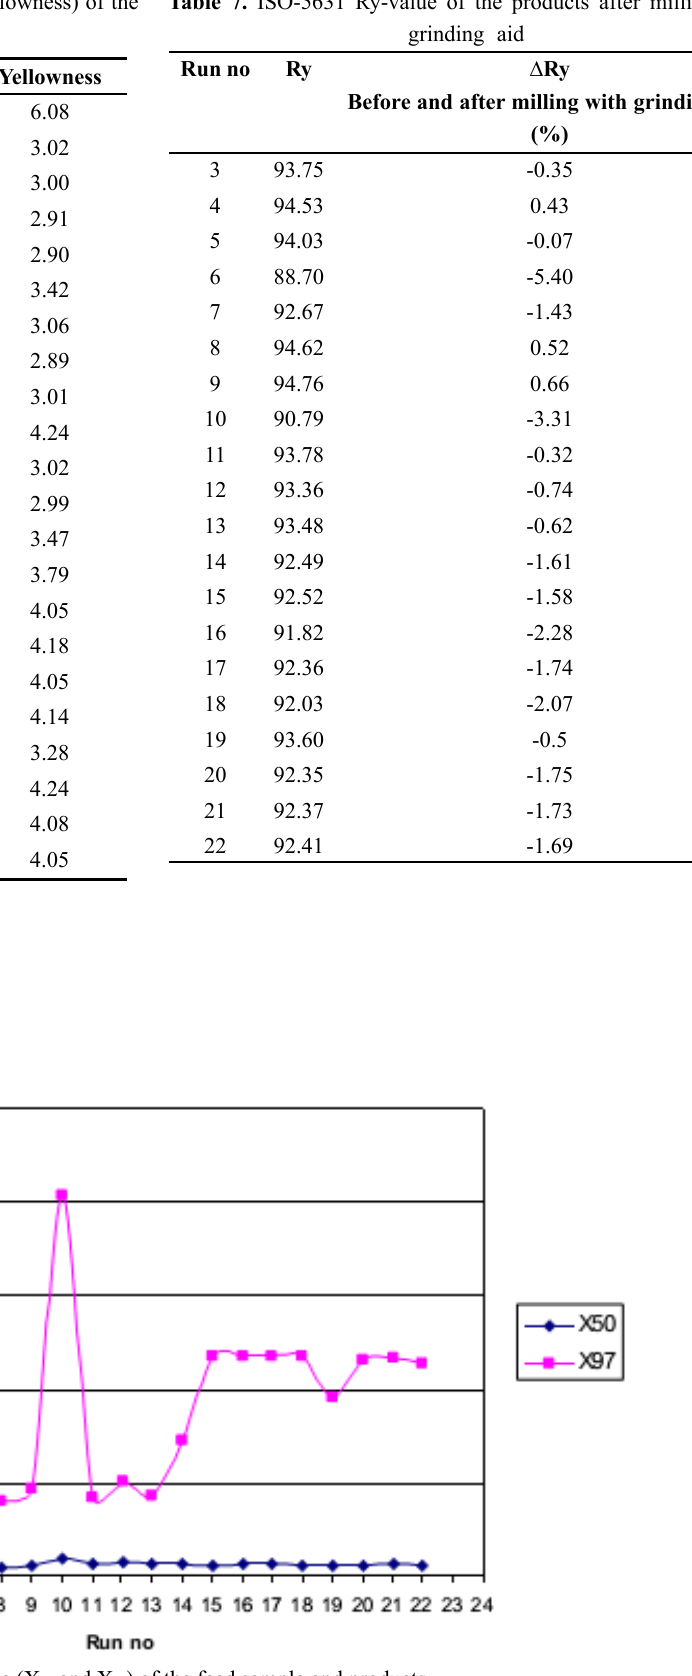
and X ) of the feed sample and 50 97